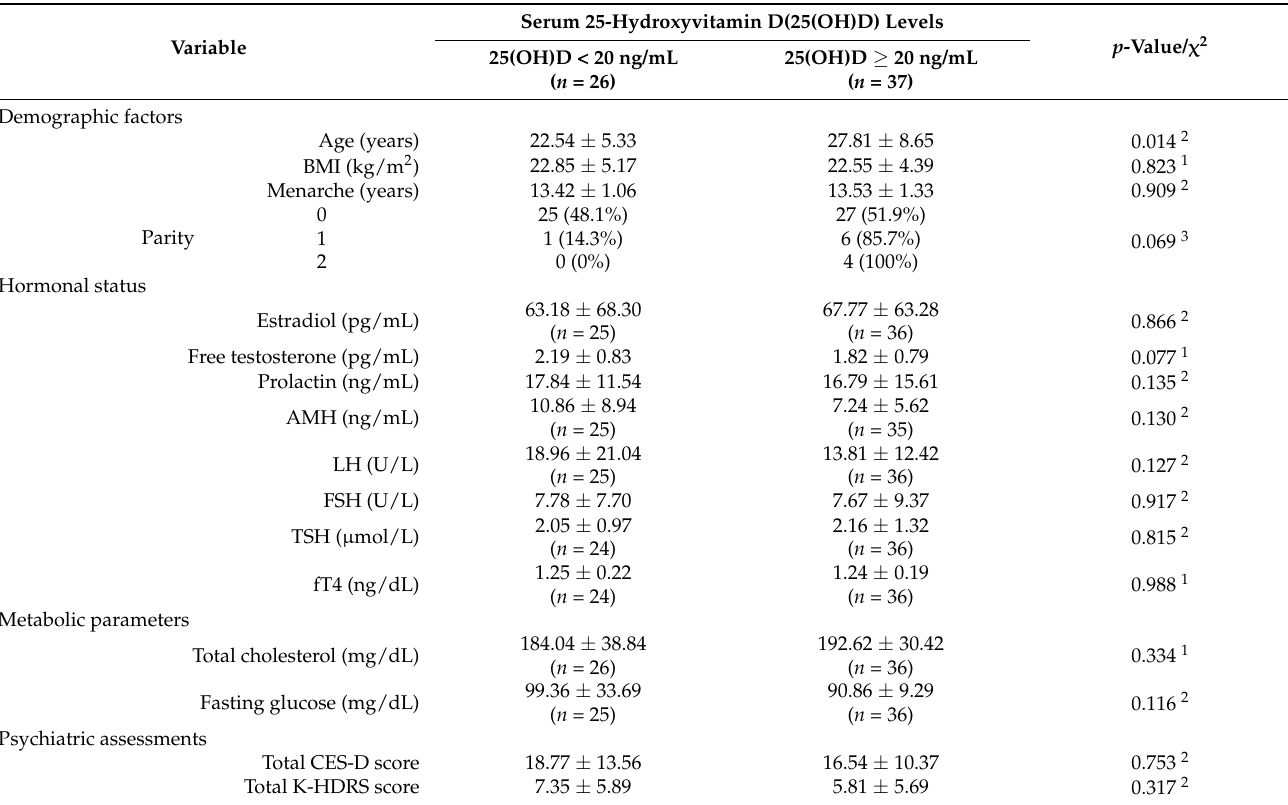
Table 1. Demographic and clinical characteristics according to serum 25-hydroxyvitamin D levels among 63 women with secondary amenorrhea.